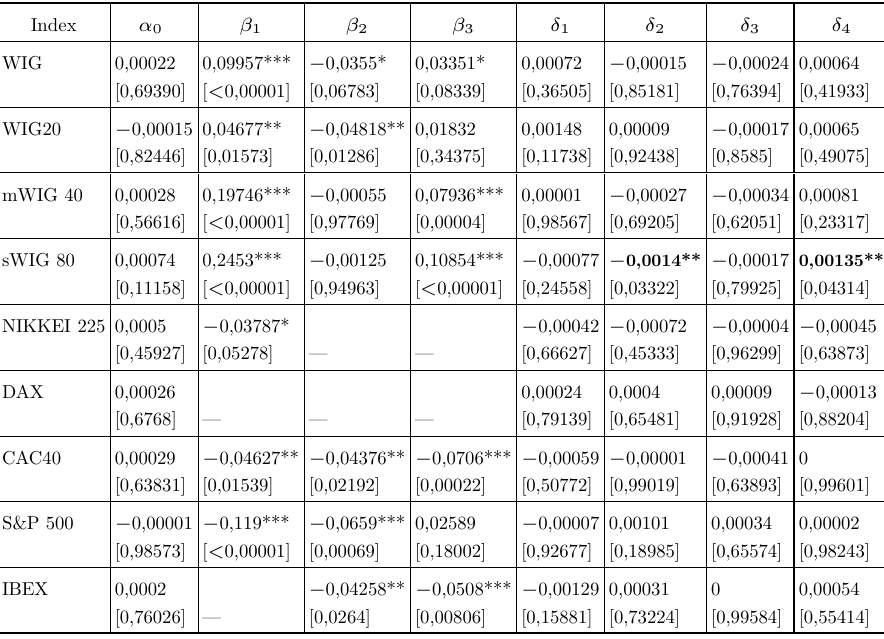
Results for the period: January 2003 – September 2013 (whole